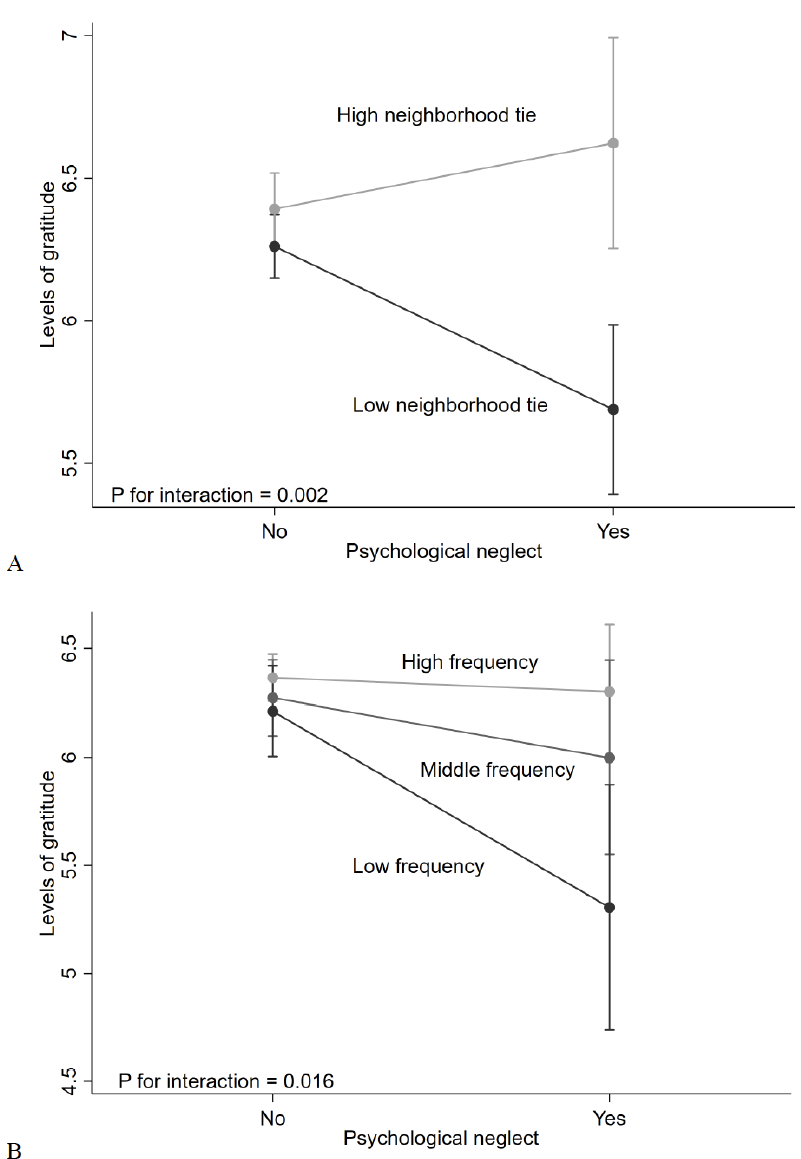
Figure 1. Association of emotional neglect with the levels of gratitude stratified by the levels of social ties: ( A ) the levels of neighborhood ties and ( B ) the frequency of meeting